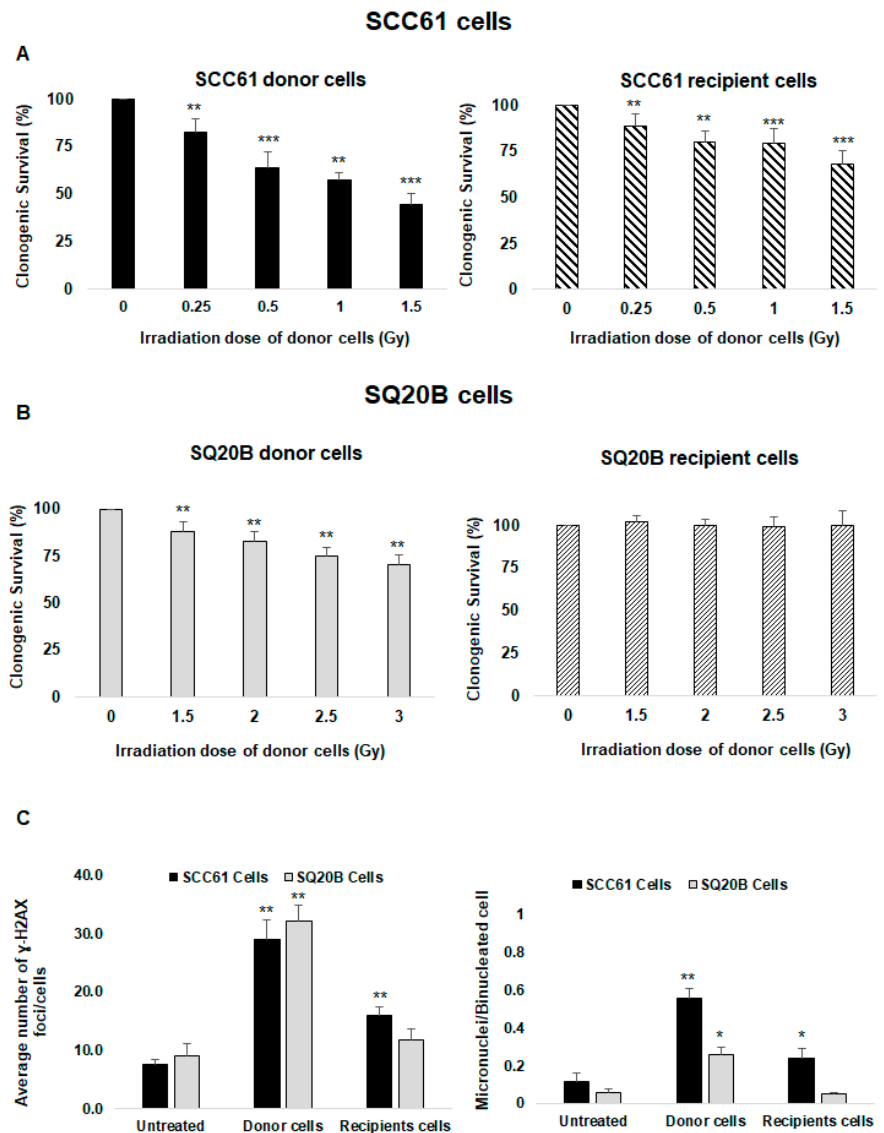
Figure 1. Assessment of targeted and nontargeted effects: clonogenic survival assays were performed in donor and recipient cells 12 days following X-ray irradiation (donor cells) or incubation in culture medium in which donor cells had been cultured for 2 h (recipient cells) as described in the Materials and Methods section. Survival was measured in ( A ) SCC61 cells and ( B ) SQ20B cells. ( C ) The average numbers of H2A.X foci and micronuclei per cell were determined using immunofluorescence assay in SCC61 and SQ20B donor cells (1.5 Gy and 3 Gy, respectively) and in corresponding recipient cells. The results are the mean ± SD of three experiments performed in triplicate. * p < 0.05, ** p < 0.01, and *** p < 0.001 compared with untreated